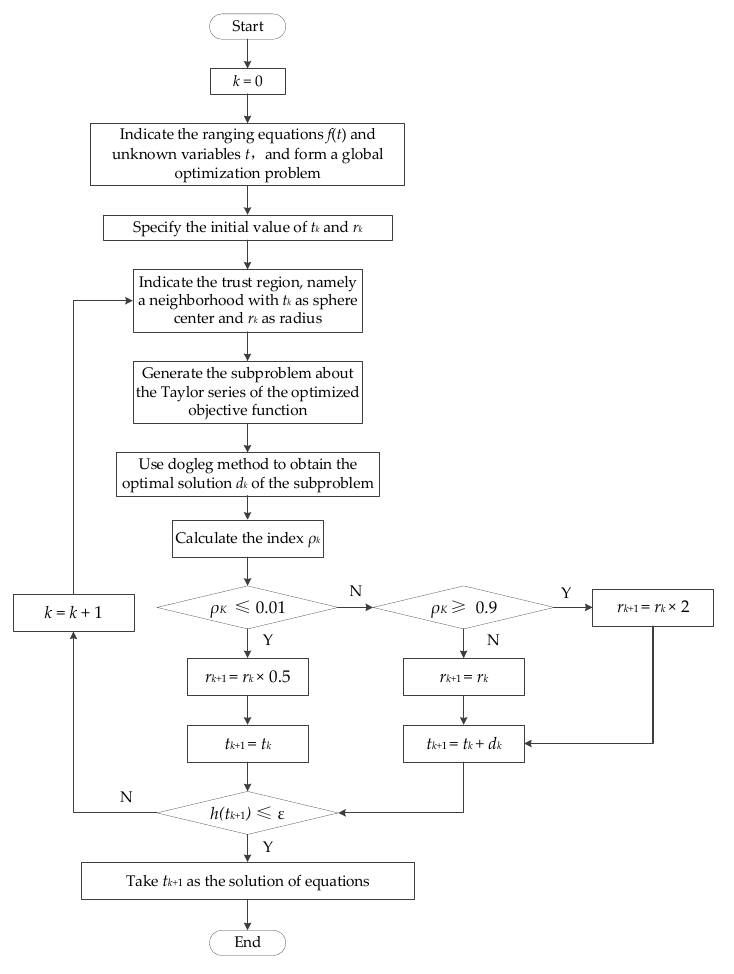
Figure 3. Flowchart of solving by trust-region algorithm.